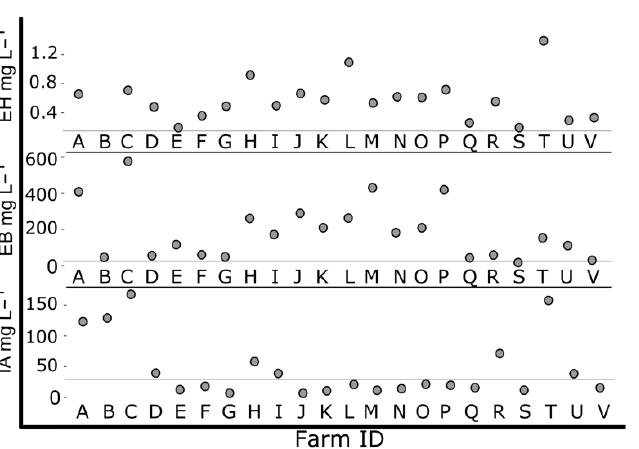
Figure 7. Estimated concentrations of three esters in “Jewel” across regional farms in New York State. Esters: ethyl hexanoate (EH), ethyl butanoate (EB), isoamyl acetate (IA). Fruits collected between 6 June and 3 July 2018. Gray horizontal line indicates threshold for ester flavor detection: Nasal threshold of ethyl hexanoate at 0.16 m%, orthonasal threshold of ethyl butanoate at 20 m%, and orthonasal threshold of isoamyl acetate at 30 m%.